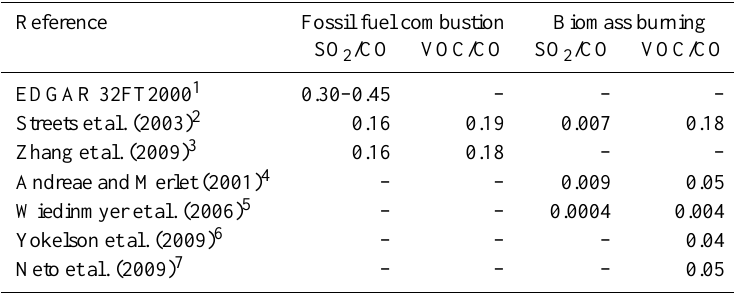
Table 5. Emission ratios of gaseous sulphur and gaseous organic compounds from fossil fuel (FF) and biomass burning (BB) based on several emission inventories and